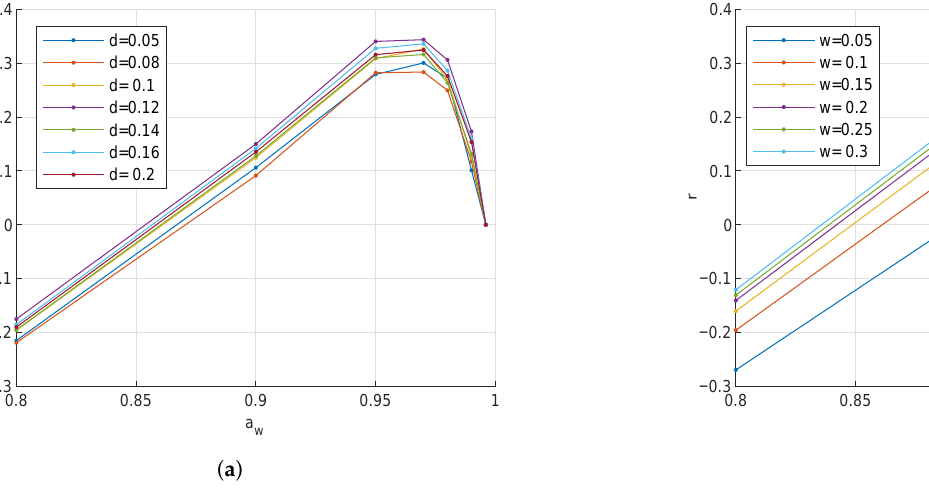
Figure 7. Relative sensitivity analysis of the interdigitated conductance electrode at 1MHz. ( a ) Relative sensitivity r with varying electrode gap: Parameter d is the electrode gap between the electrode fingers in mm. The electrode width was kept at 0.1mm. An optimum in sensitivity is reached with an electrode gap at d ∼ 0.12mm. ( b ) Relative sensitivity r with varying electrode size: Parameter w is the electrode width of the electrode fingers in mm. The electrode gap was kept at 0.1mm. Increasing the electrode width increases the